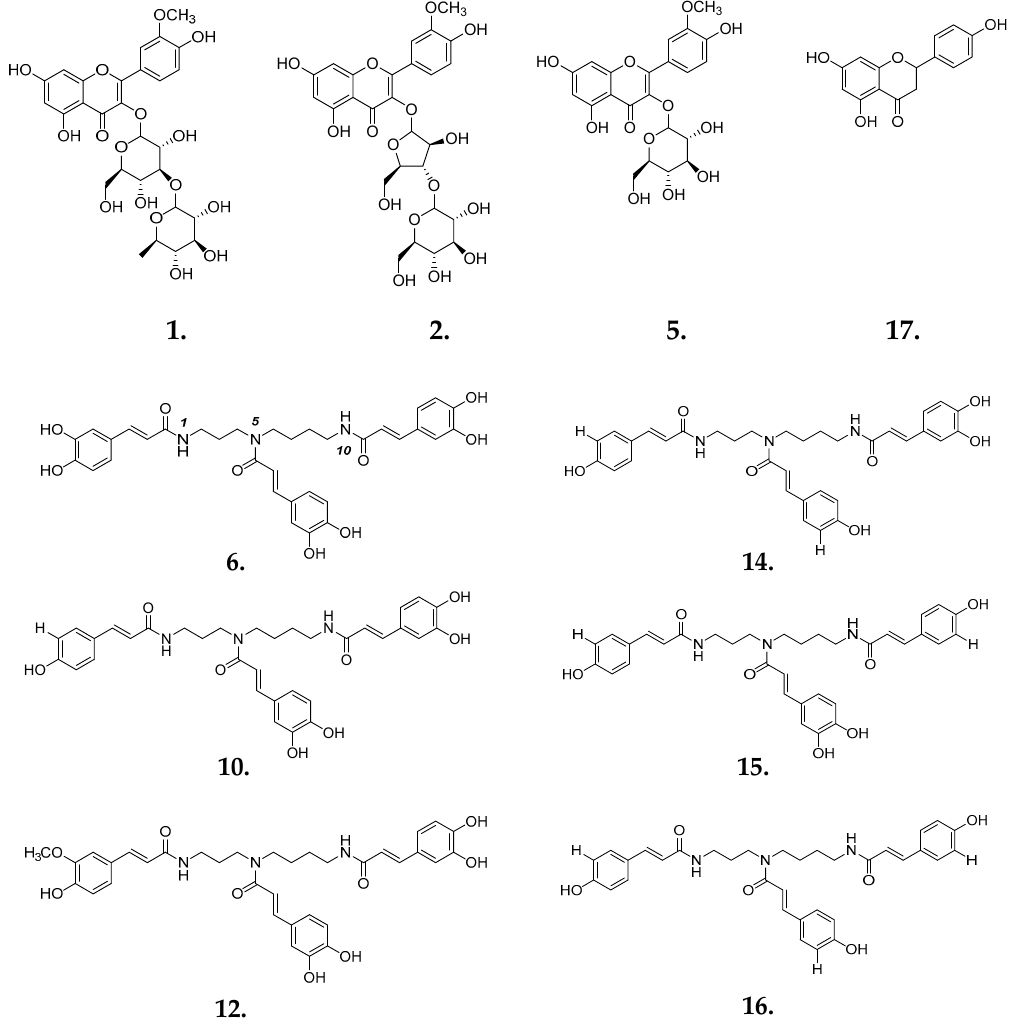
Figure 2. Proposed structure of the flavonoids and phenolamides found in Castanea pollen.